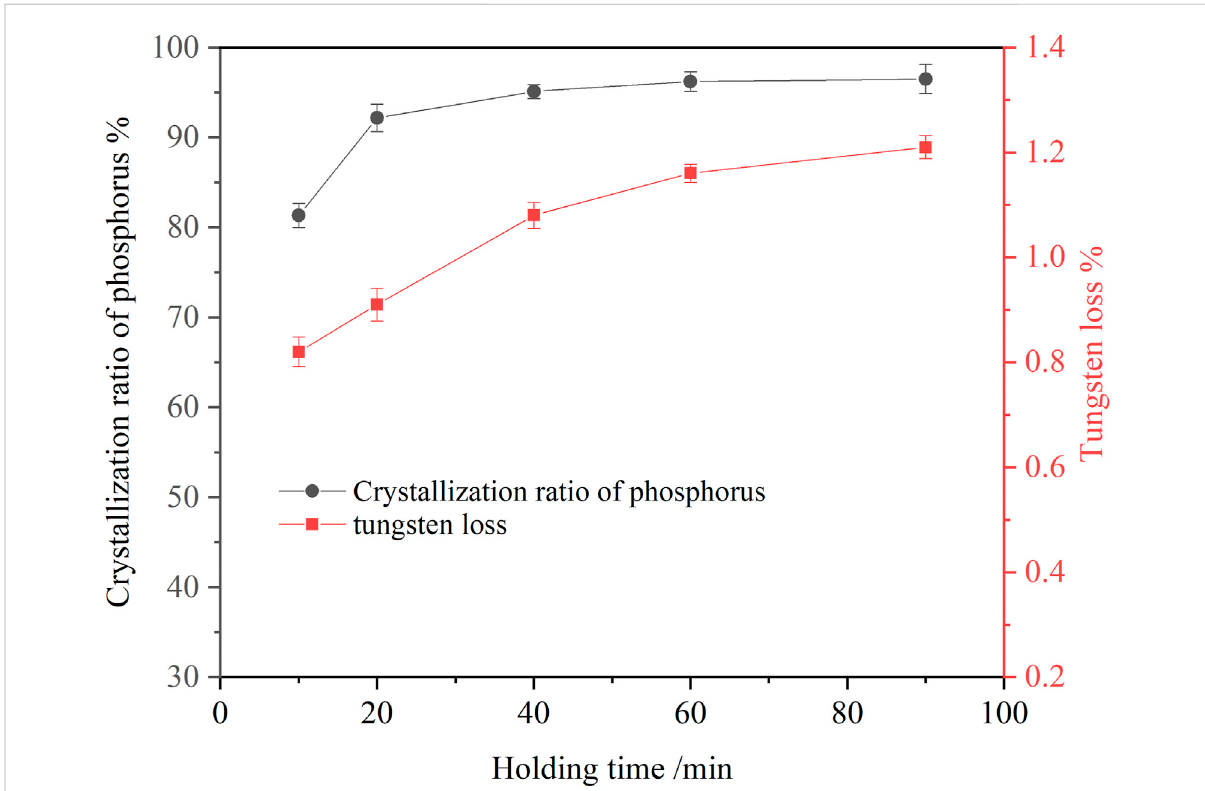
FIGURE 4 Effectofholdingtimeoncrystallizationofammoniumphosphate(ammoniaconcentration4.18 mol/L,P24.58 g/L,temperature20 ° C,agitation speed 250 rpm).